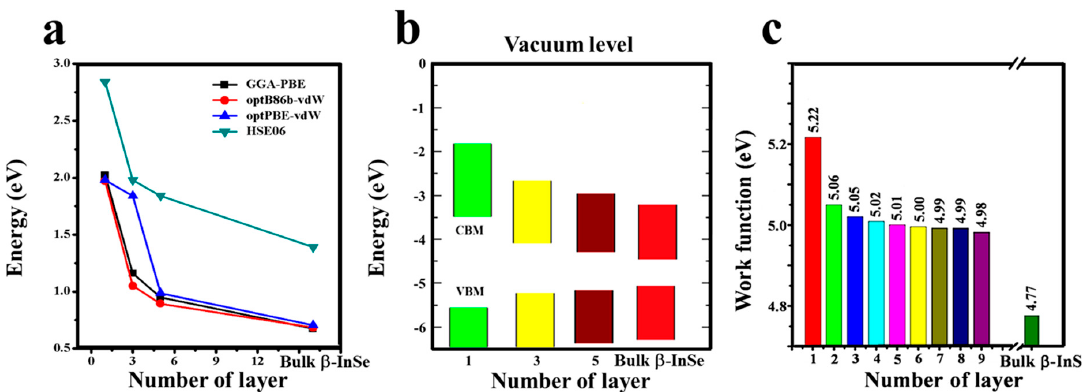
Figure 4. ( a ) Band gap energy of monolayer (1 L), few-layer (3 L and 5 L) and bulk β -InSe as a function of number of layers from various functionals ( b ) Schematic representation of band alignment of monolayer (1 L), few-layer β -InSe (3 L and 5 L) and bulk β -InSe, determined from HSE06 calculations. Vacuum is set as zero for reference. ( c ) Work function of few-layer β -InSe as a function of number of layers.